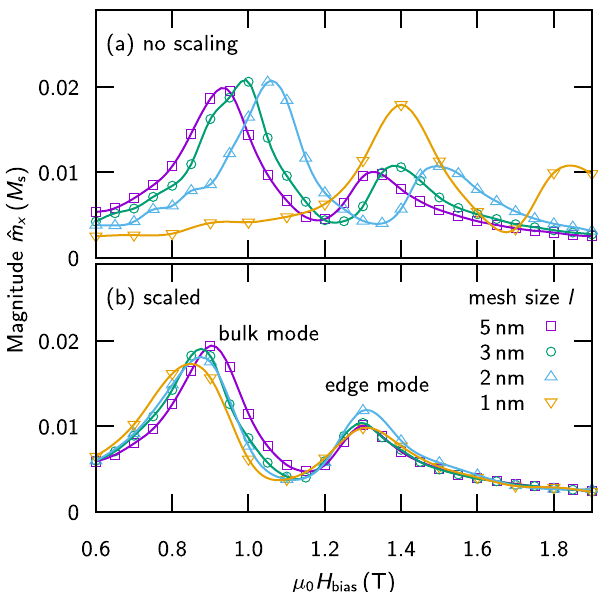
. The s Fig. 4 FMR curves including magnetostatic fi eld. FMR curves for different mesh sizes l of a small cube computed by ( a ) sLLG without parameter scaling and ( b ) with scaled intrinsic properties. While the symbols mark the computed results, the lines are spline interpola- tions serving as guide to the eye. The two peaks of each curve correspond to the bulk and edge mode.